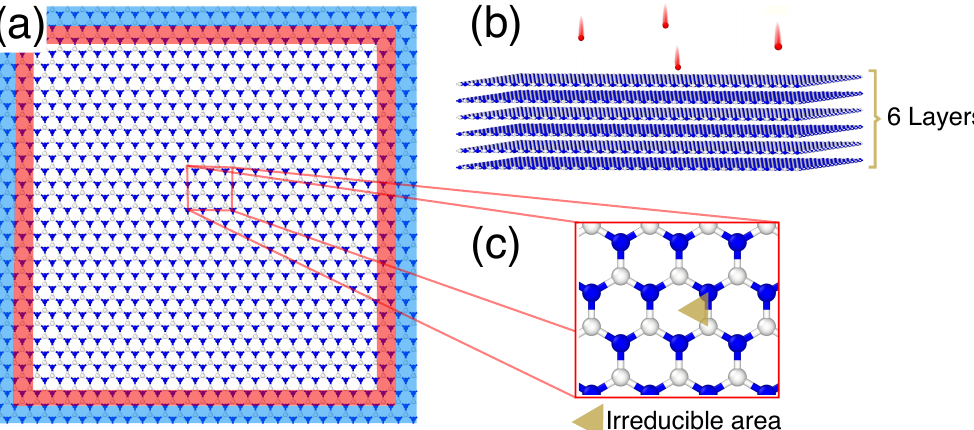
Figure 1. Simulation setup for monolayer ( a ) and multilayer ( b ) h-BN target. The outermost atoms (blue) were kept fixed during the irradiation simulations to avoid target displacement. The kinetic energies of the atoms were scaled in the areas indicated by red using Berendsen thermostat to describe energy dissipation at the borders of the simulation cell. ( c ) The irreducible area used in the single-ion-impact